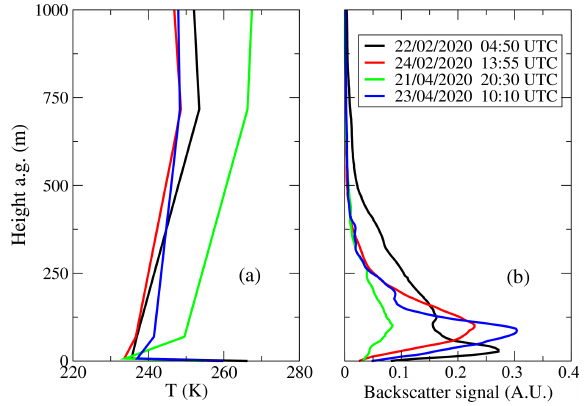
Figure 16. (a) Retrieved temperature profiles during the selected days of measurement. (b) Backscattering lidar signal in arbitrary units for the analyzed measurements.